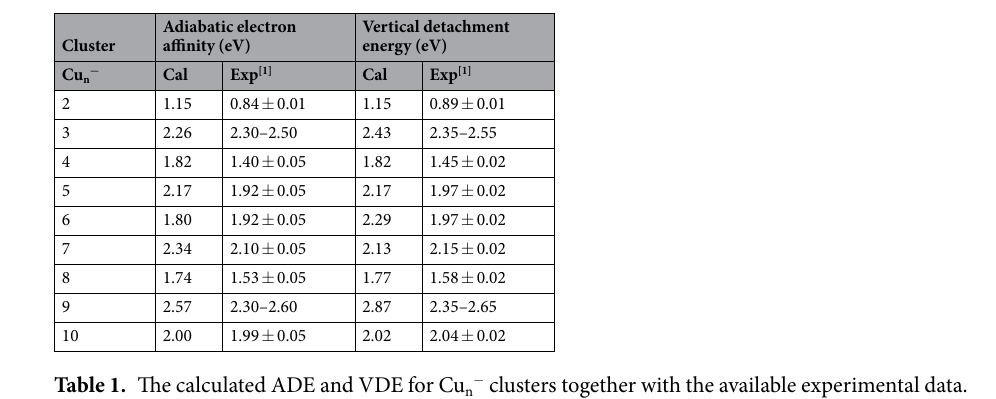
Table 1. The calculated ADE and VDE for Cu n − clusters together with the available experimental